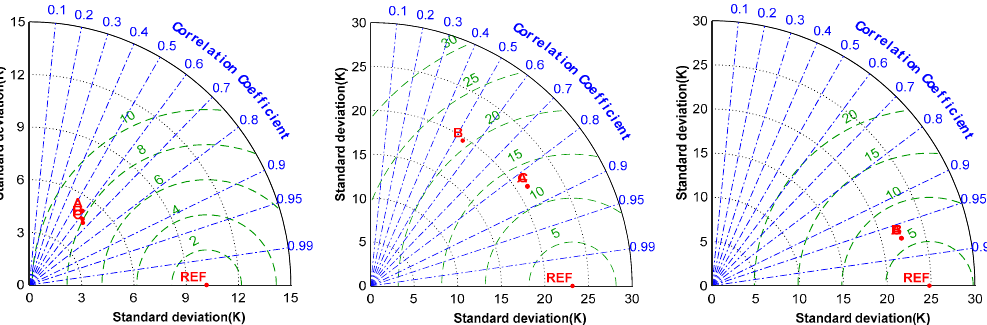
Figure 12. Taylor diagrams showing statistical comparisons between the observations and simulated SWE at 3-hour intervals between 0:00 on 1 November 2014 and 21:00 on 31 March 2015 using different air temperatures above which all precipitation is rain (Tr) at the three sites.